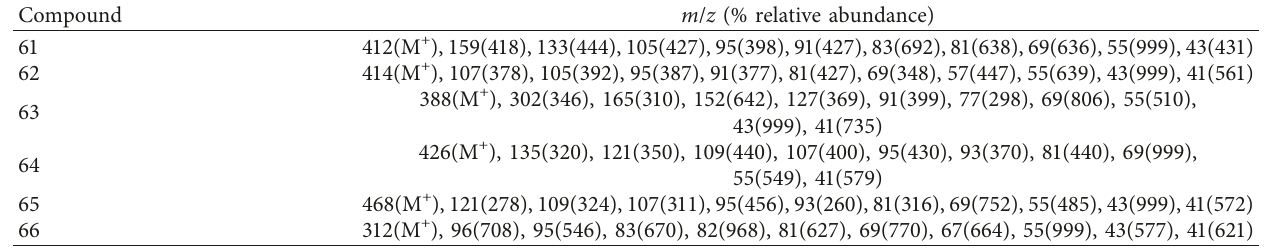
Table 27: Mass spectra of compounds 61–66 of whole plant n -hexane fraction of Achillea wilhelmsii (WHFAW). Compound